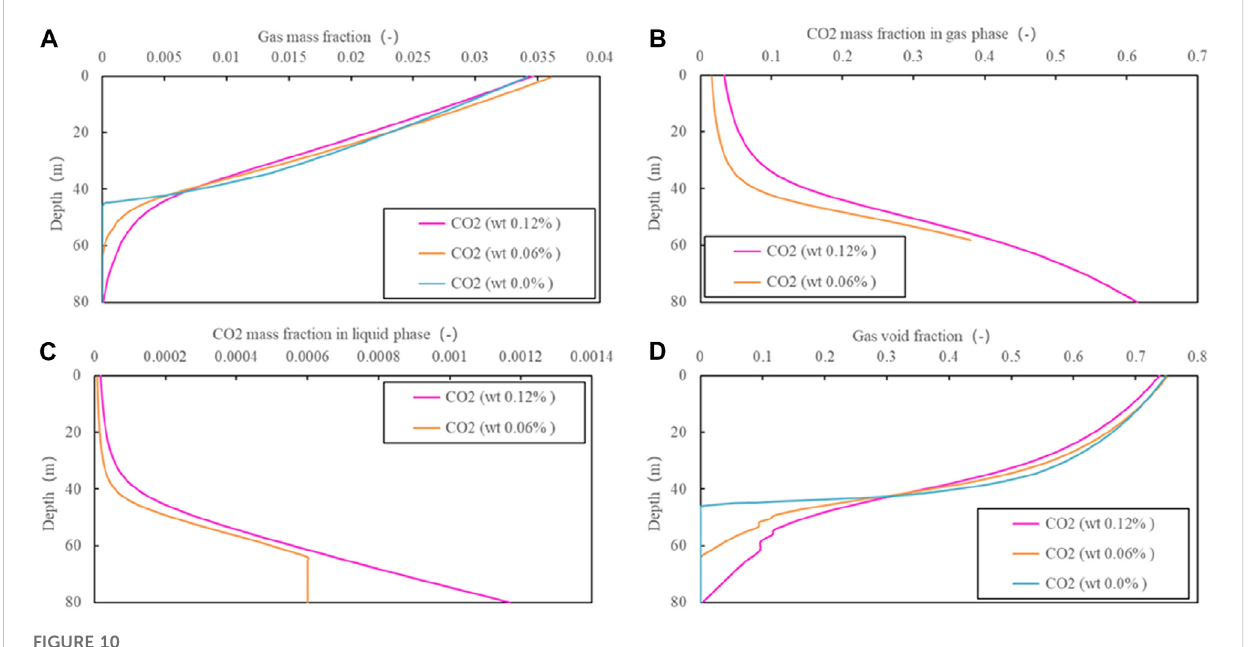
FIGURE 10 Simulated results by Shi et al. model for ZK324.